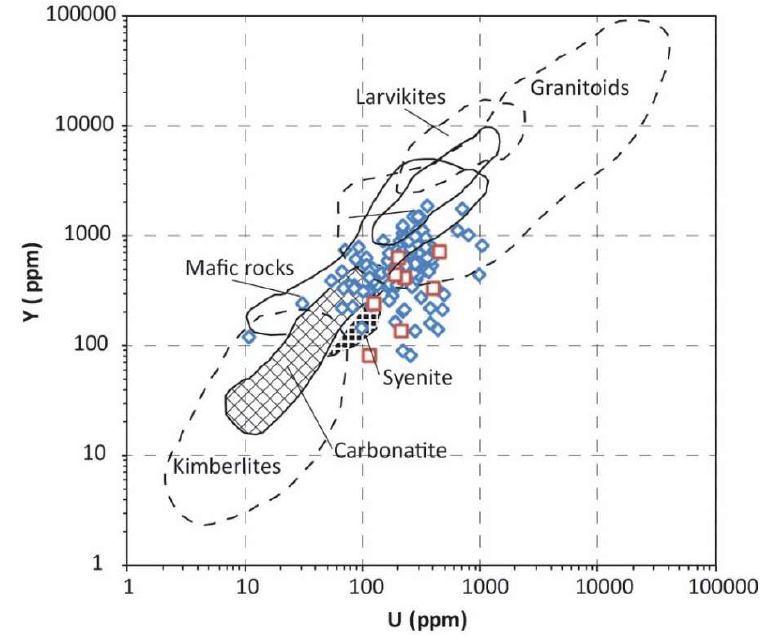
Figure 7. Y versus U plot of western Meiganga magmatic zircons (adapted from [19,54], blue and white diamond-shape plots are for magmatic zircons; red and white square plots are for metamorphic zircon).